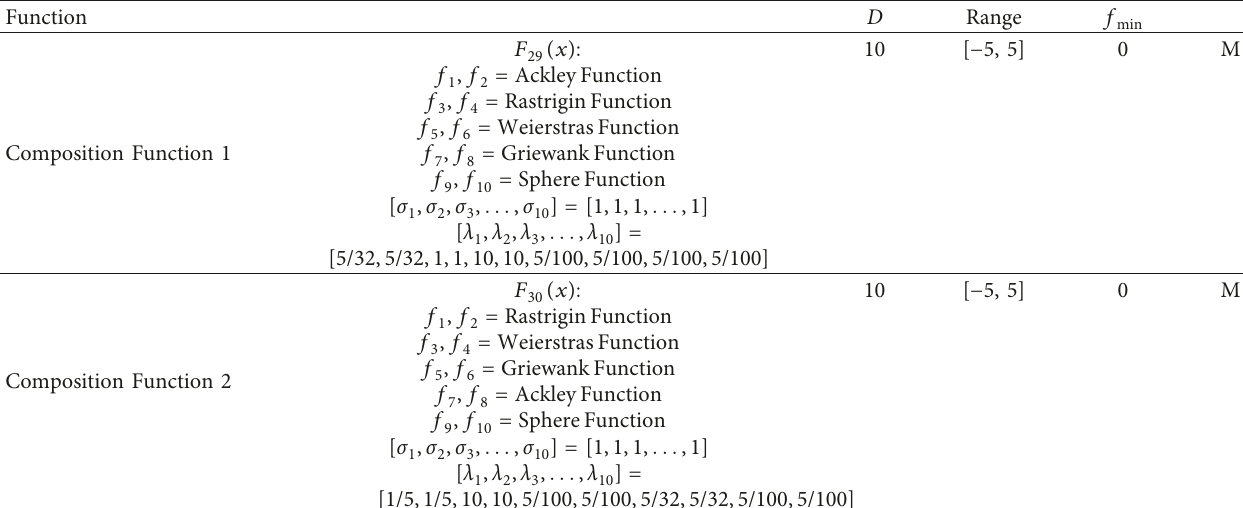
Table 5: Benchmark